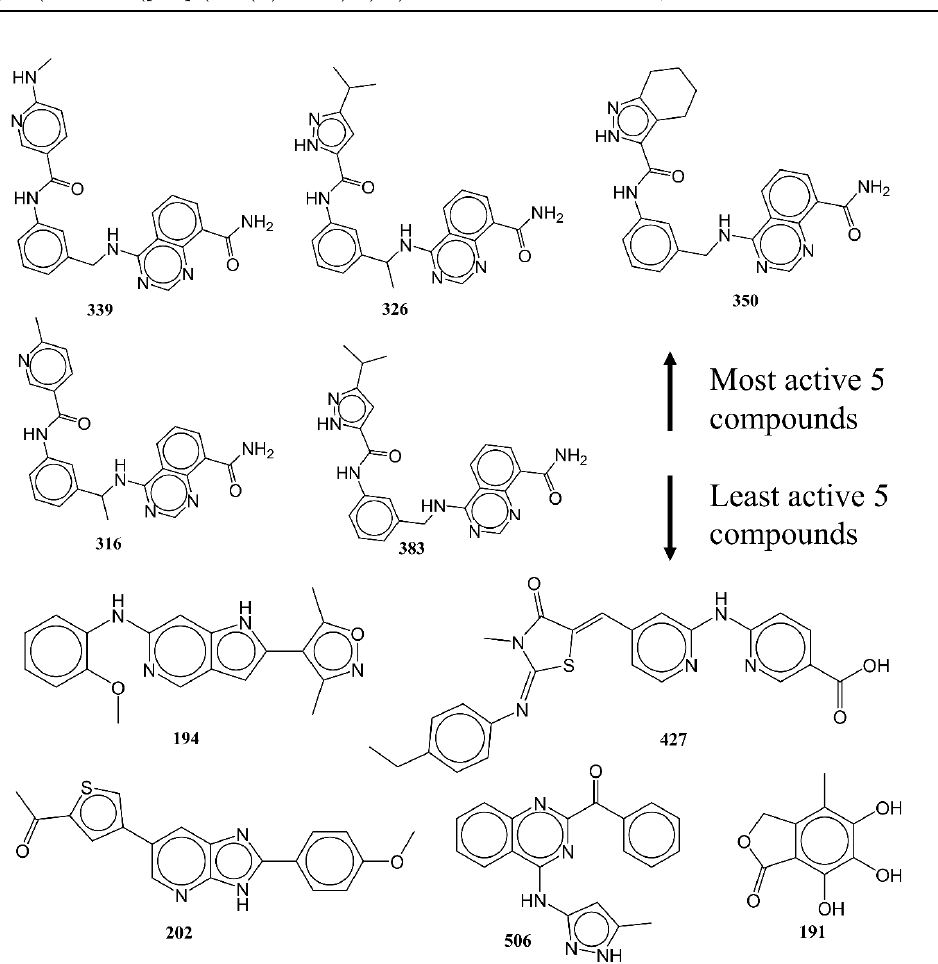
Figure 12. Representative examples from the selected dataset (five most active and five least active molecules).